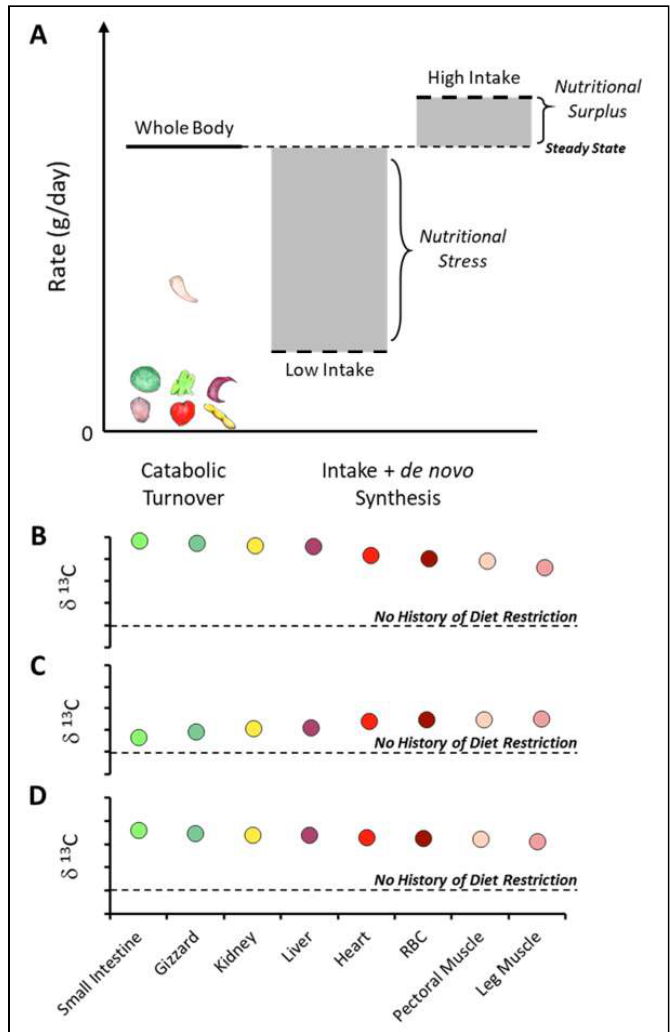
Figure 3. Schematic illustrations of the influence of turnover on nutritional state and isotopic reconstructions of nutritional status. The balance between whole-body catabolic turnover rate (summed from individual tissue turnover rates denoted by tissue icons) and the rate of dietary intake, along with de novo synthesis, can be used to assess an individual’s nutritional status ( A ), with low